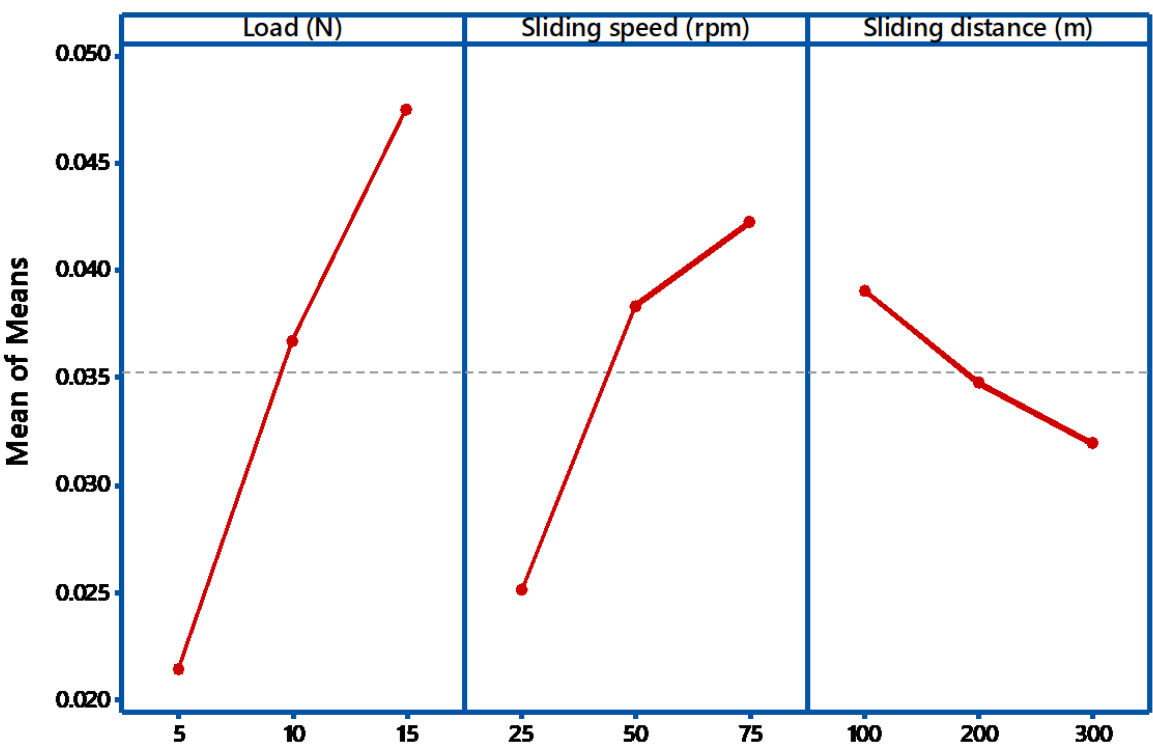
Figure 4. Main effect plot (Mean).